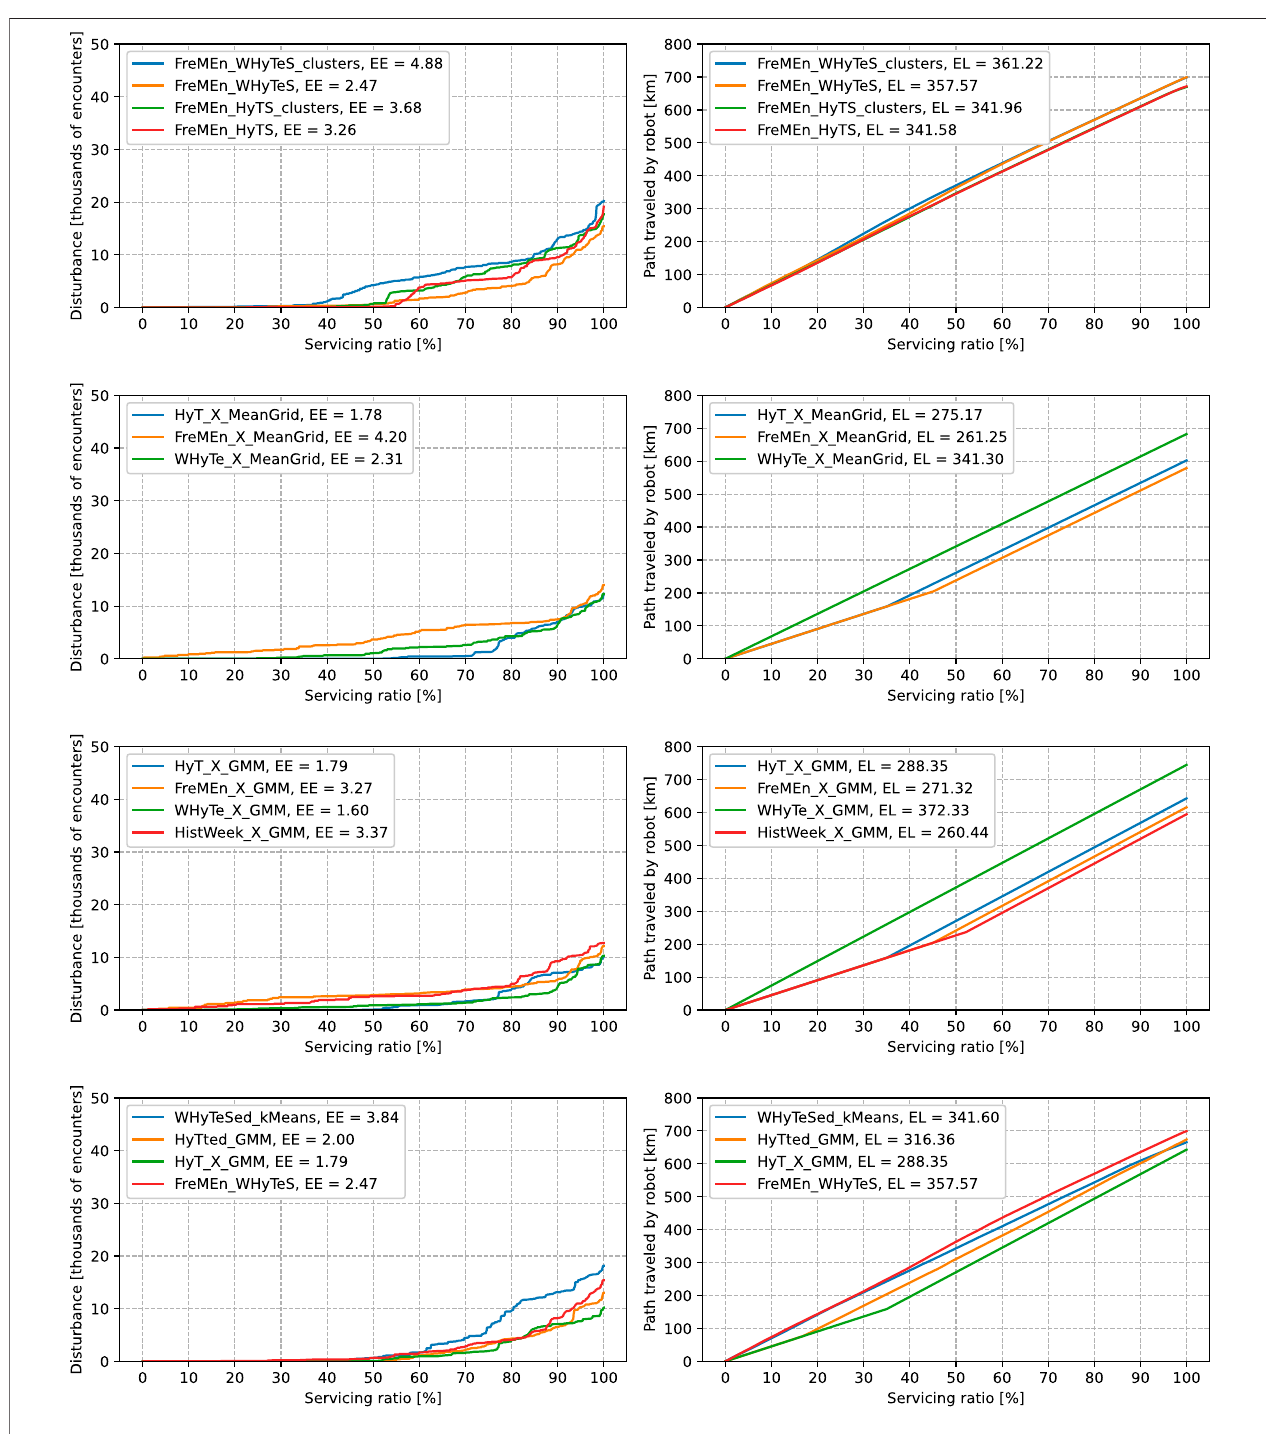
FIGURE 6 | Comparison of different models in the spatio-temporal scenario. The left columns of graphs depict service disturbances, the quantile functions of the ordered human – robot encounters. The right columns of graphs depict traveled distances, the quantile functions of lengths of paths. The labels in graphs consist of names of models and the expected